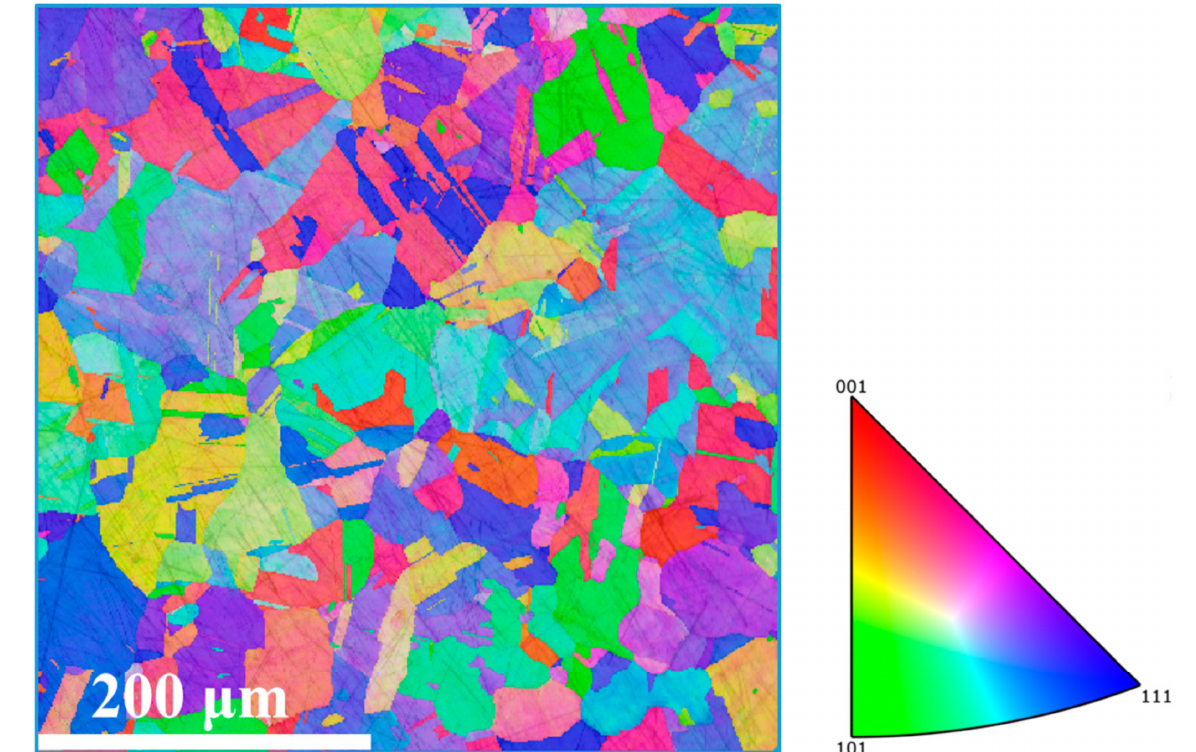
Figure 4. The EBSD inverse pole figure (IPF) of initial sample.